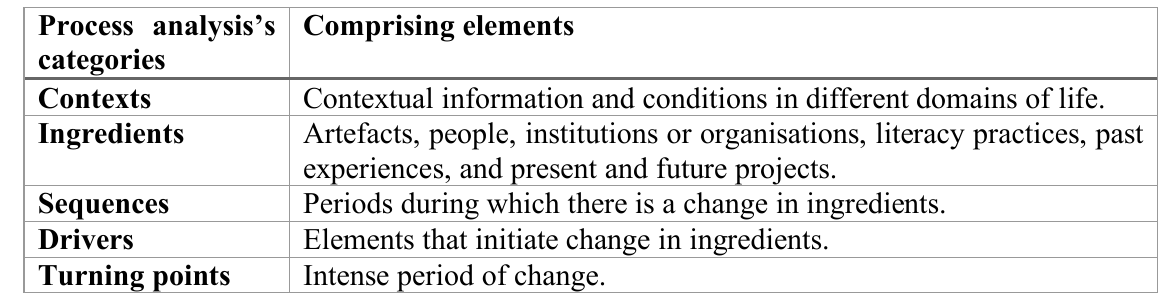
Table 1: Brief overview of the Process analysis’s categories Process